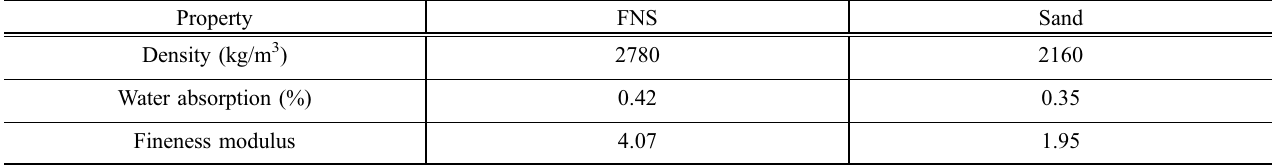
Table 3 Physical properties of ferronickel slag and natural sand.